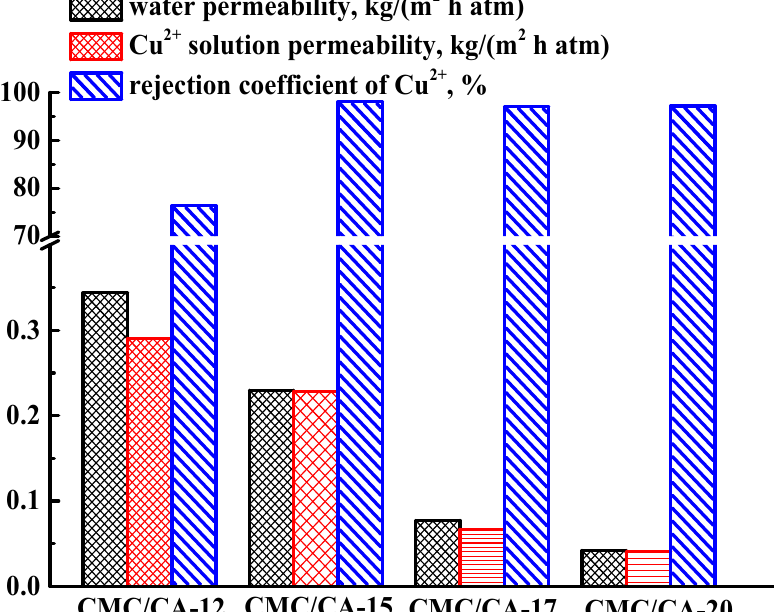
Figure 7. Transport properties of the supported CMC/CA membranes in nanofiltration of water and model Cu 2+ solution.